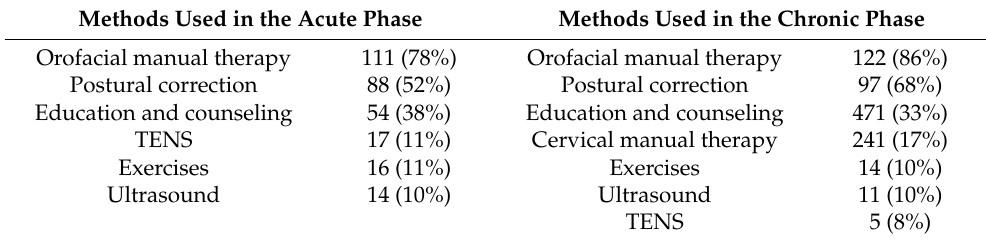
Table 4. Methods used to treat patients with TMD ( n =